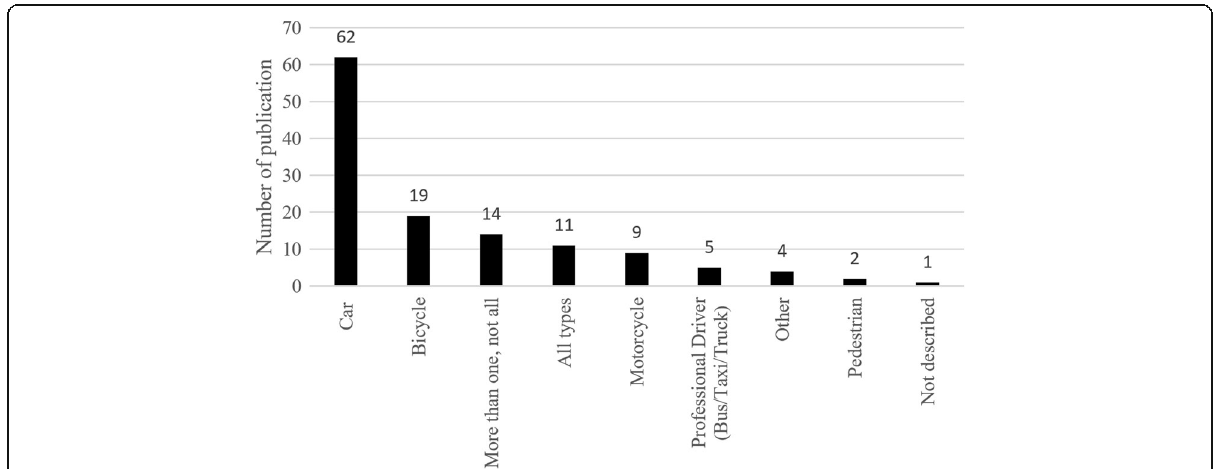
Fig. 5 Type of road users involved in the traffic crashes